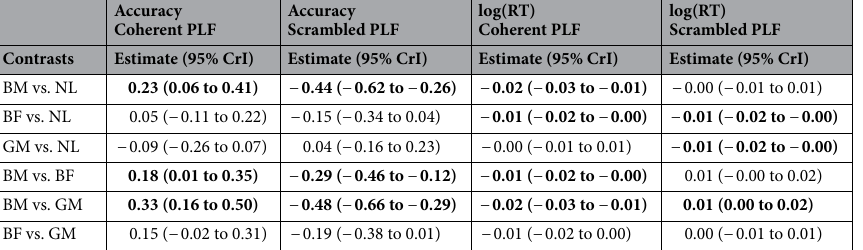
compared to general motion cues, followed by no language cues, and was smallest compared to biological form cues (see Supplementary Fig. S1). For scrambled PLFs (target absent condition; mean accuracy: 89.17%; see Fig. 2), the model showed the highest false alarm rate (lowest correct rejection) on trials with biological motion cues compared to the other